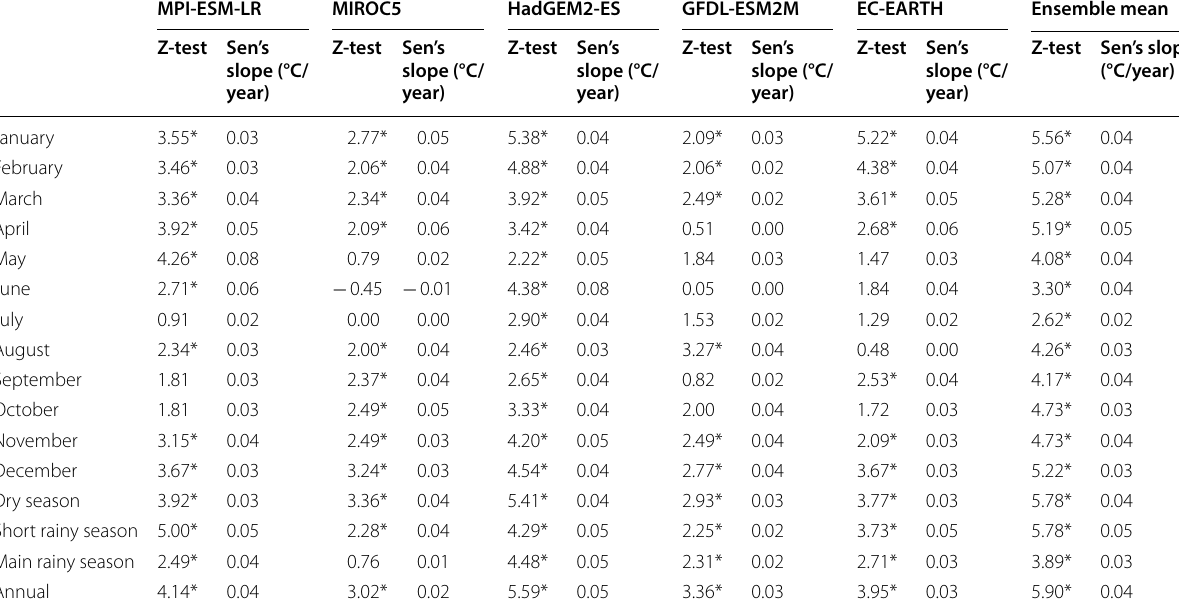
* Statistically significant at 0.05%